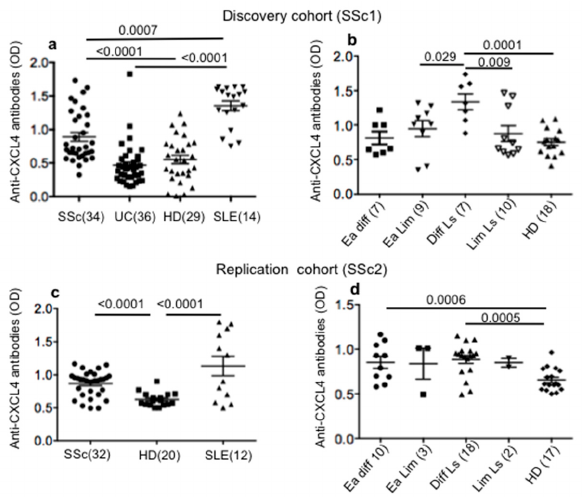
Figure 1. Anti-CXCL4 antibody reactivity is present in SSc patients. Sera (SSc1) ( a , b ) and plasma ( c , d ) (SSc2) and sera / plasma (see Table S1) of HD (healthy donors), UC (ulcerative colitis) and SLE